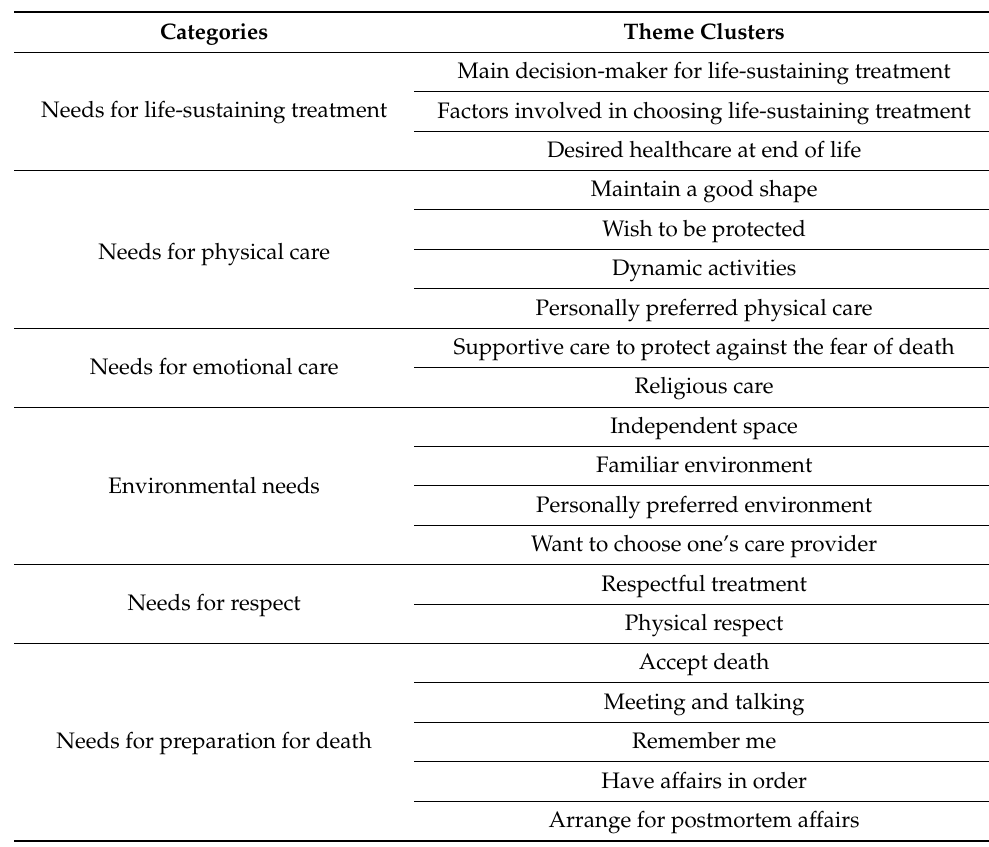
Table 2. Main categories and theme